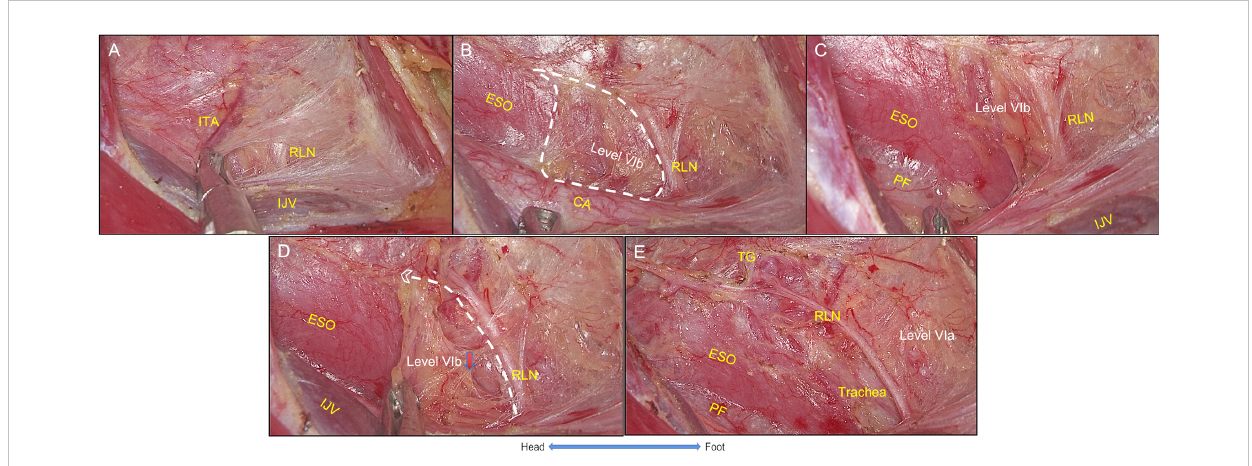
FIGURE 3 The settlement of esophagus. (A) The right RLN was identi fi ed at the starting point. (B) The buccopharyngeal fascia was dissected to expose the esophagus and level VIb, and ITA was ligated. (C) The posterior boundary of the surgical space should be prevertebral fascia. (D) The right RLN was traced toward to the ending point, while Level VIb was settled. (E) The settlement of esophagus was completed. RLN, recurrent laryngeal nerve; IJV, internal jugular vein; ITA, inferior thyroid artery; CA, carotid artery; PF, prevertebral fascia; ESO, esophagus; TG, thyroid gland. White lines with angle represent cutting